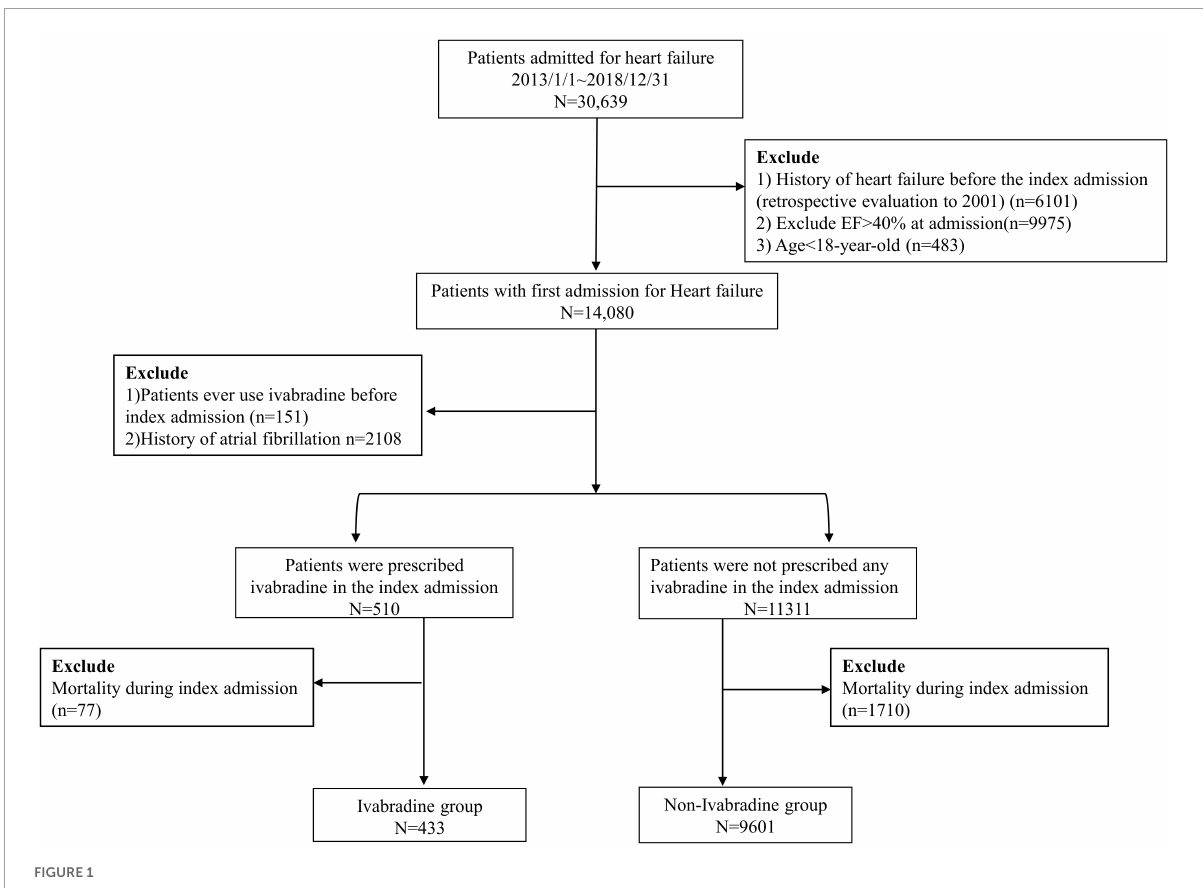
FIGURE1 Flowchart of the study